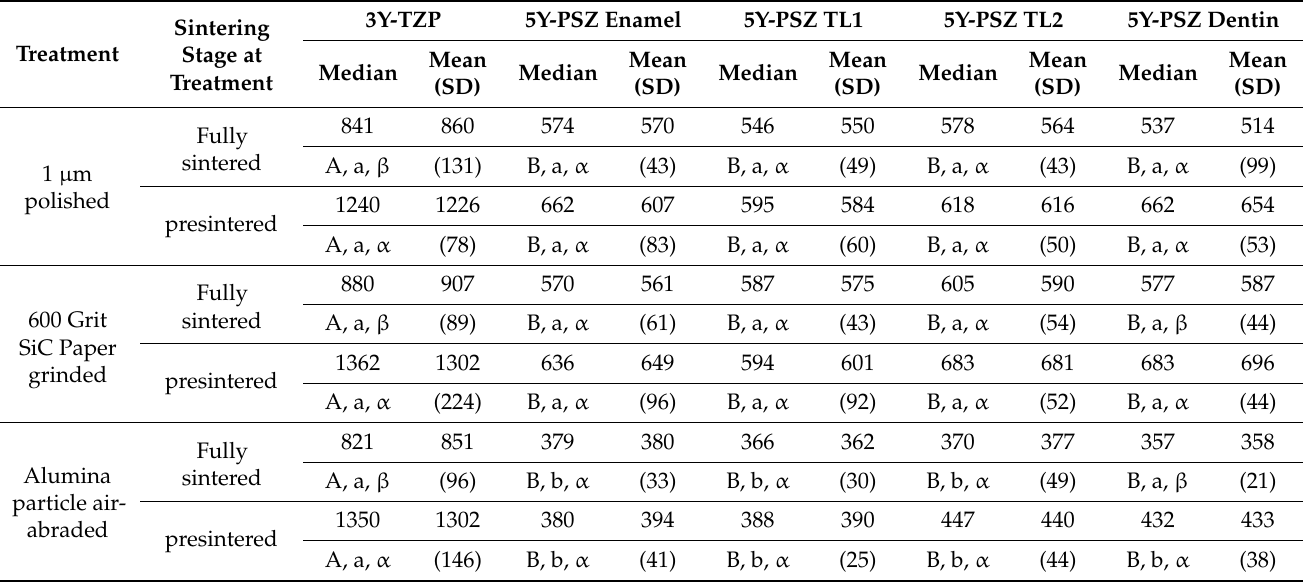
Table 5. Medians, means and standard deviations in MPa of the biaxial flexural strength of test groups (N = 10) measured with ball-on-three-balls test. Statistically different medians ( p ≤ 0.05) are indicated by different upper-case letters (within a column for analysis of the different materials with the same surface treatment), or by subscript lower-case letters (within a row for the same material with different surface treatment), or by different lower-case Greece letters (comparison of the cutting before and after